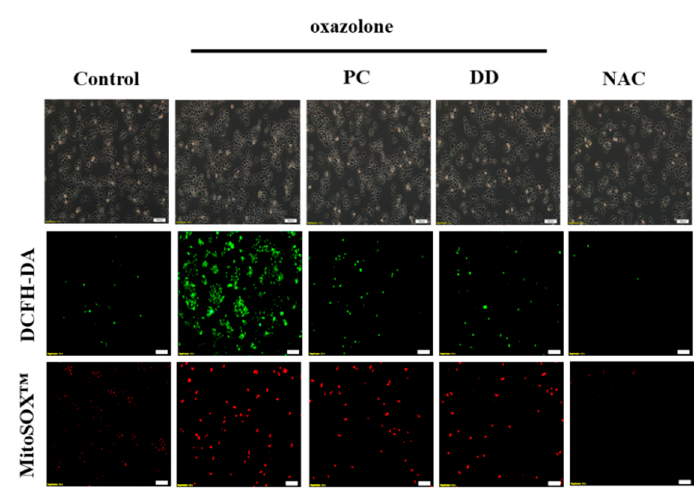
Figure 2. The effect of P. cicadae and D. dasycarpus on the oxidative levels of HaCaT cells exposed to oxazolone. HaCaT cells were sensitized with oxazolone and treated with P. cicadae or D. dasycarpus . The generation of cellular ROS were measured by the 2 ′ ,7 ′ -dichlorofluorescin diacetate (DCFH-DA), whereas mitochondrial superoxide generation was analyzed by using MitoSOX™ Red as a probe. N-acetylcysteine (NAC) was used as an antioxidant control. Representative micrographs (40×) demonstrating. P. cicadae and D. dasycarpus effectively prevented oxazolone-produced cellular and mitochondrial superoxide in HaCaT cells.